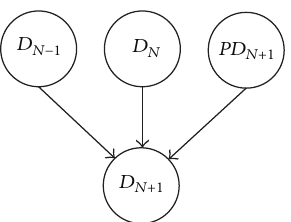
Figure 3: The structure of Bayesian network-based drought fore- casting